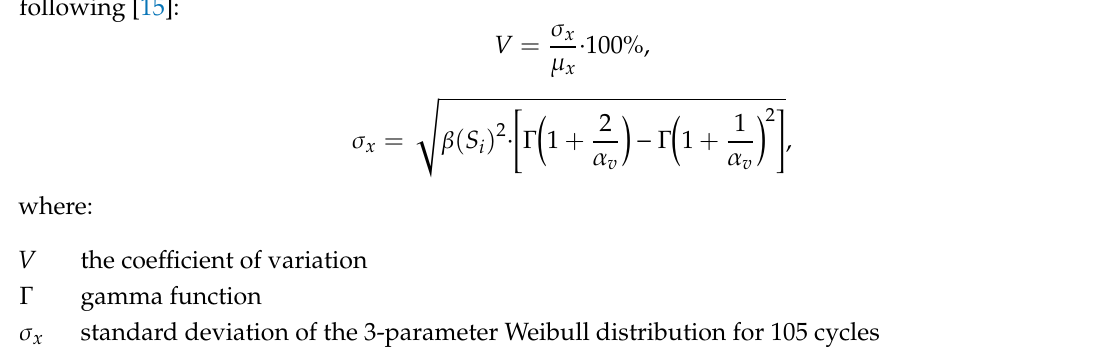
Figure 7. S–N curves for 1.4301 steel with 5% and 95% probability of failure. Table 4. Value of linear regression parameters for the 1.4301 steel.